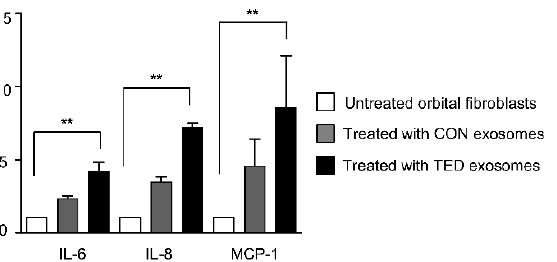
Figure 4. Tear-derived exosomes stimulate cytokine production on normal orbital fibroblasts. The concentrations of IL-6, IL-8, and MCP-1 were measured by ELISA analysis. The mean cytokine concentrations of untreated cells were set to 1.0, and the fold-changes were calculated. The data shown are presented as mean fold-change ± SD ( n = 5). Statistical differences were determined using a paired t-test (** p < 0.01). CON—control subject; TED—patient with thyroid eye disease.